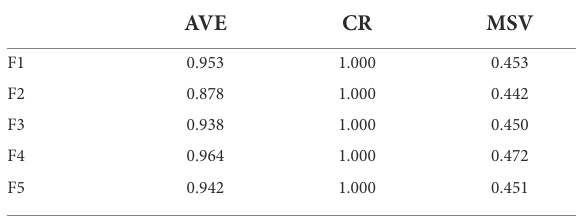
TABLE 5 Coefficients for factor loading.